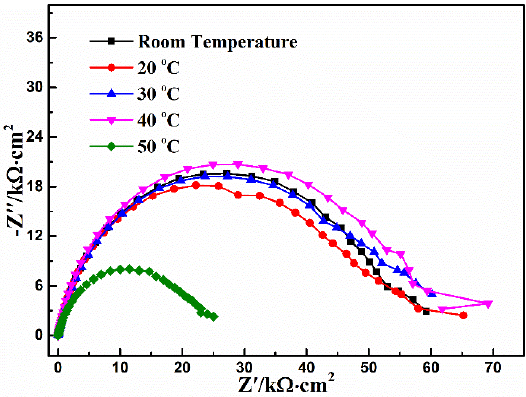
Figure 5. Experimental Nyquist plots of coated AZ91D samples obtained from different conversion temperatures. Table 4. The fitting results of EIS shown in Figure